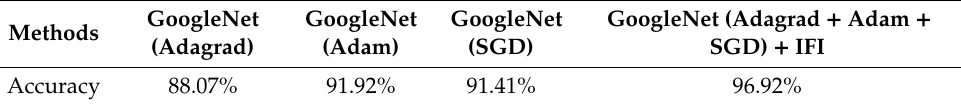
Table 11. Recognition results of GoogleNet architectures with di ff erent optimization method.